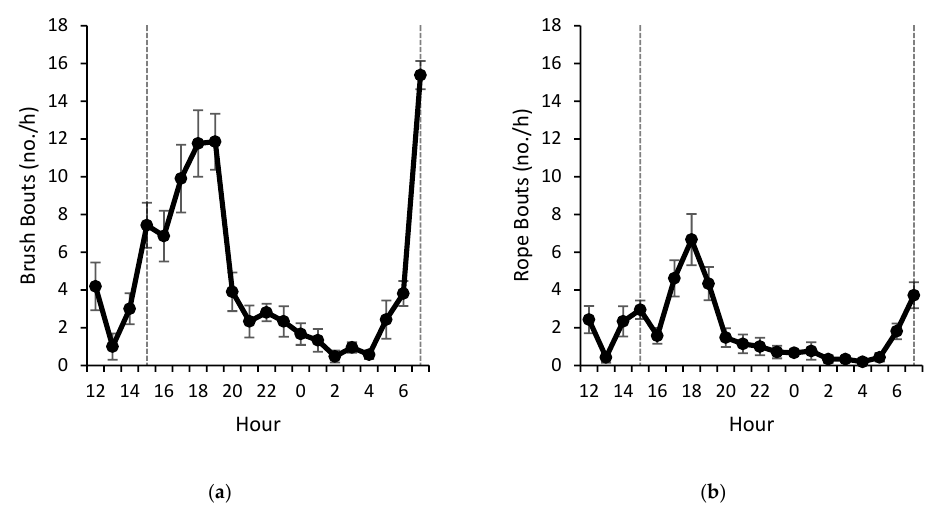
Figure 3. Mean (± SEM) number of ( a ) brush and ( b ) rope bouts for 7 calves averaged for 3 days (d1, d3, and d6). Observations spanned from 12:00 to 08:00 the following day. Calves were fed 4 L of whole milk from a 5-nipple milk feeder twice daily at 07:00 and 15:00 (dotted line); feeders were left in the pen for 30 min to ensure the full milk meal was consumed.